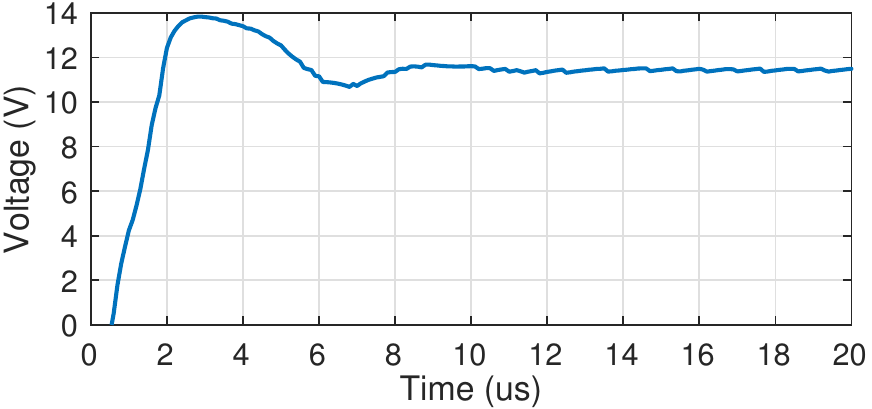
Figure 5. Simulation of the startup of the DC-DC converter. The output settles at a 11.5V output voltage in roughly